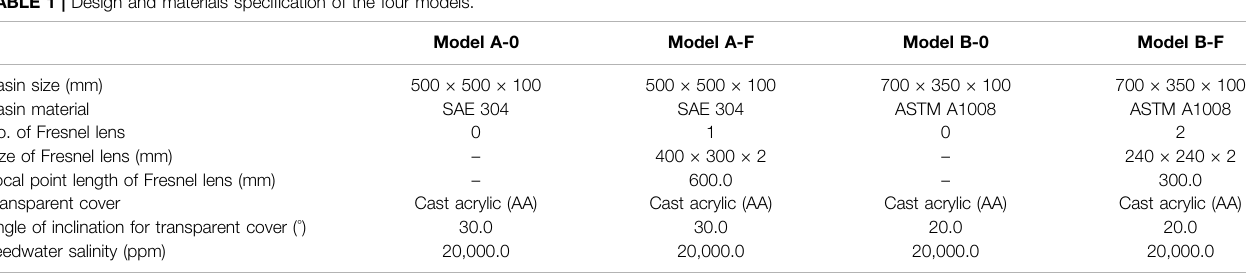
TABLE 1 | Design and materials speci fi cation of the four